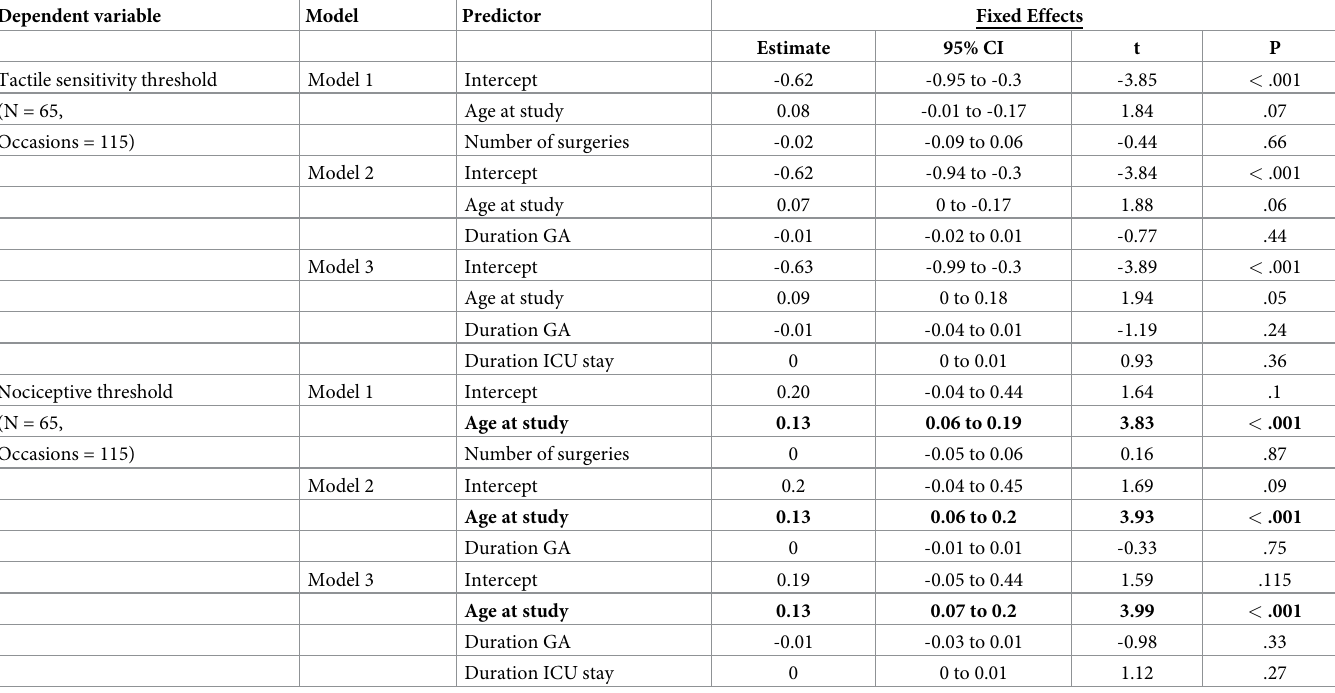
Table 4. Results of linear mixed models to test effect of age and indices of prior surgery, anaesthesia or critical illness exposure on sensory